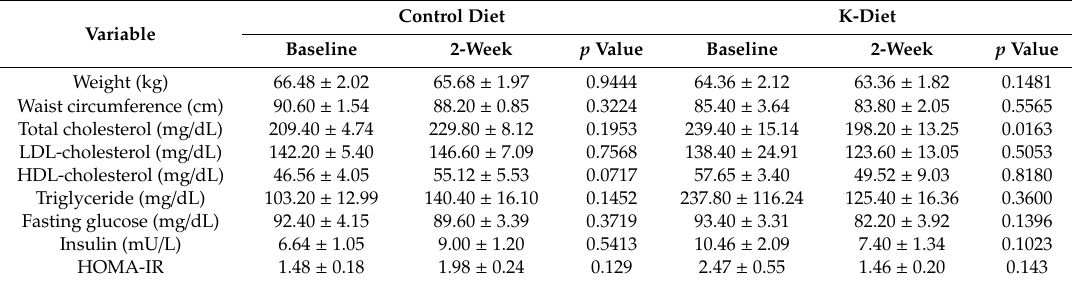
Table 2. Comparisons of clinical endpoints before and after the intervention.